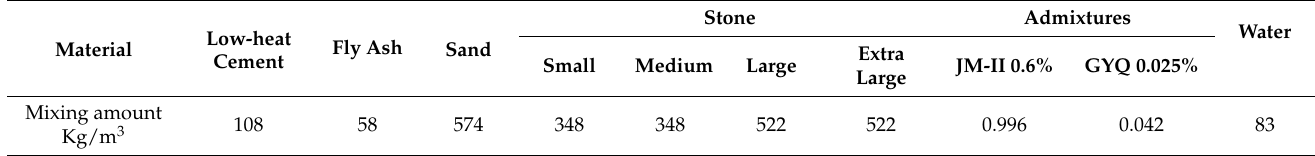
Table 3. The theoretical mixing amount of four-grade concrete.